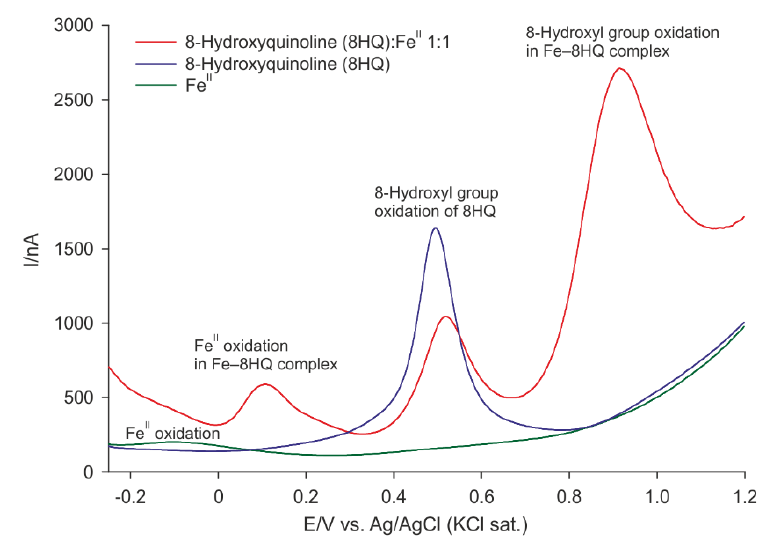
Figure 2. Differential pulse voltammograms of a 1:1 Fe II − 8HQ mixture, Fe II , and 8HQ solutions.